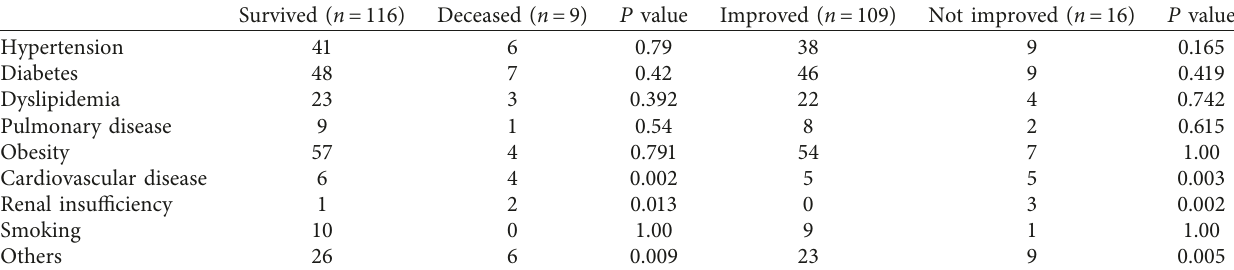
Table 2: Comorbidities of patients receiving TCZ.